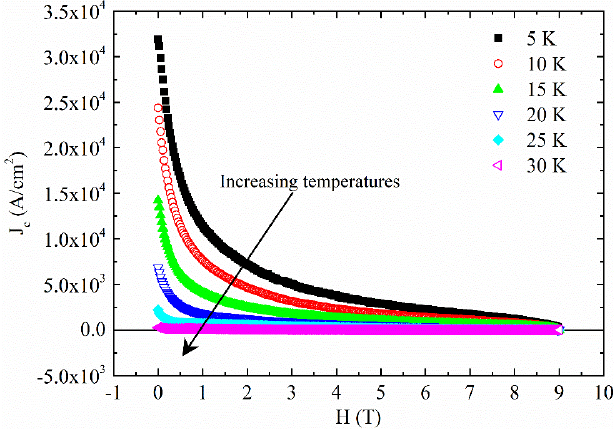
Figure 4. J c versus field at different temperatures.